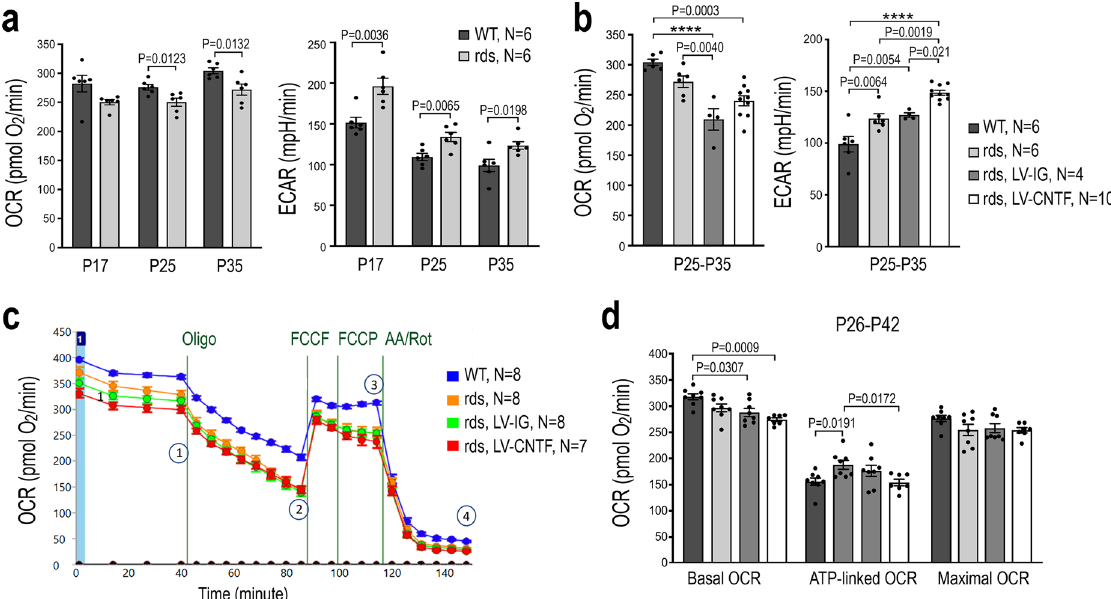
Fig. 3 | In fl uences on retinal cell respiration by the rds mutation and CNTF. a Seahorse metabolic fl uxanalysismeasuring basalOCR (left)and ECAR (right)for WT and rds retinas at P17, P25, and P35. For each age and genotype, N =6 inde- pendent retinas were used. P values from the two-tailed student t -test are indi- cated. b EffectsofCNTFonbasalOCRandECARinrdsretinastreatedwithLV-IGor LV-CNTF from P25-P35 compared to WT and non-treated rds retinas. Independent samplenumbers N andadjusted P valuesfromone-wayANOVAandTukeyall-pairs test are shown with P <0.0001indicated as****. c , d Seahorse mitochondria stress tests to determine basal and maximum OCR, as well as ATP-linked OCR by